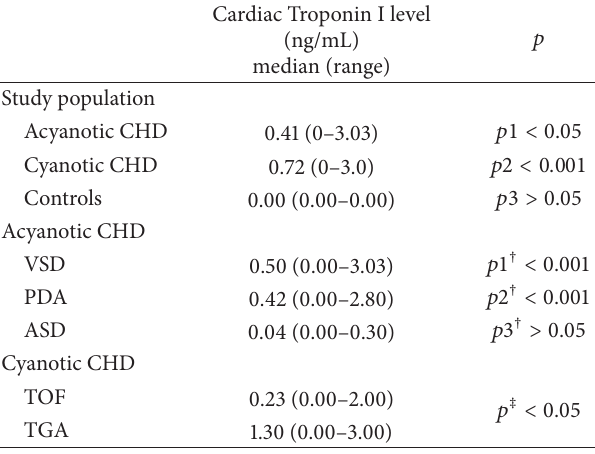
Figure 1: Box-plot shows cTnI levels in the ASD, VSD, and PDA patients. The bars represent the median and the 5th, 25th, 75th, and 95th percentiles.